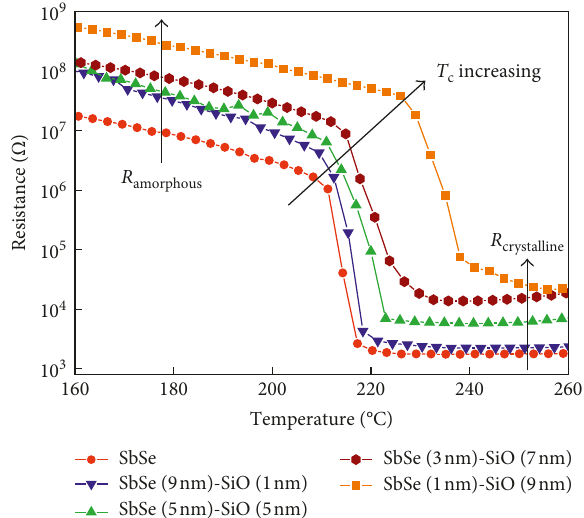
Figure 1: R-Tcurves of SbSe and SbSe/SiO multilayer thin films at a heating rate of 10 °